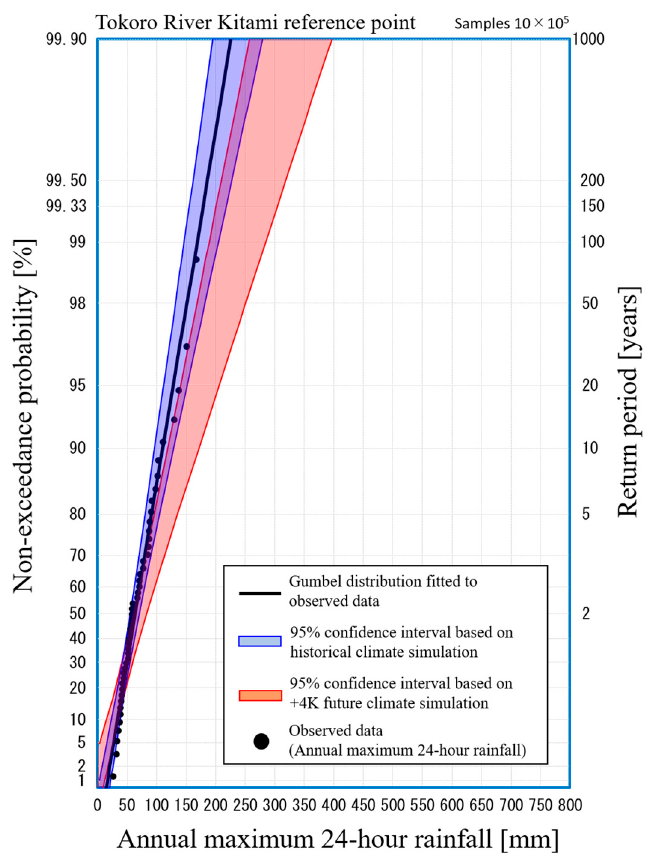
Figure 2. Observed data for annual maximum 24-h rainfall in the Tokoro river basin (black points), Gumbel distribution fitted to observed data (solid black line), 95% confidence interval on past climate (blue range), and 95% confidence interval on future climate, based on downscale calculation. Data and rendering based on previously published research [23,25,26].